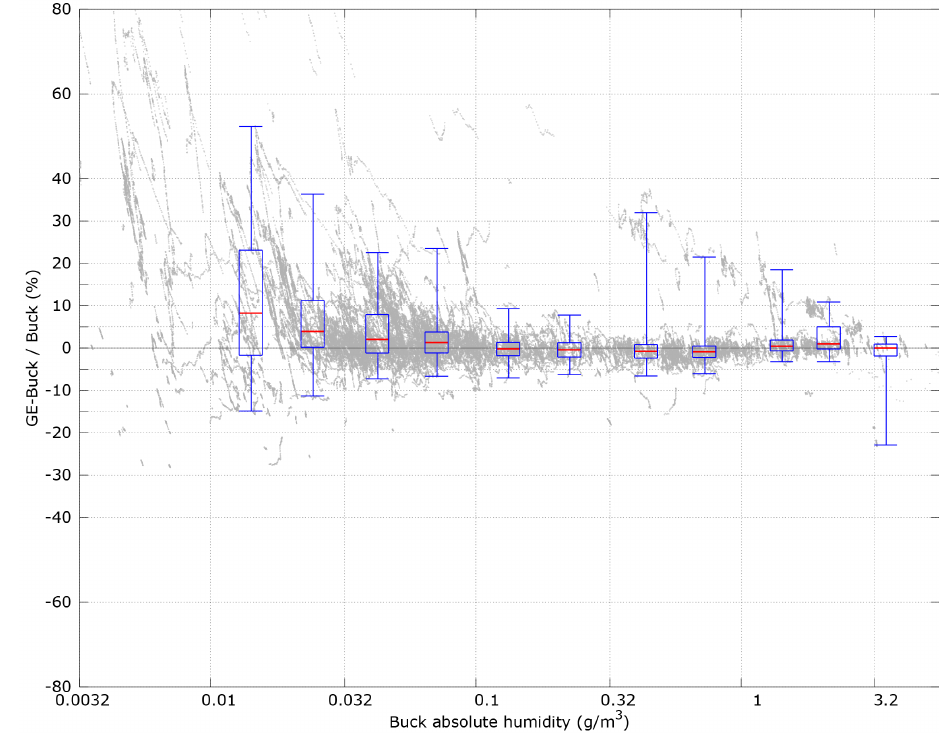
Figure 3. GE minus Buck in cloud free conditions. Boxes indicate binned quartiles, with the whiskers at 2nd and 98th